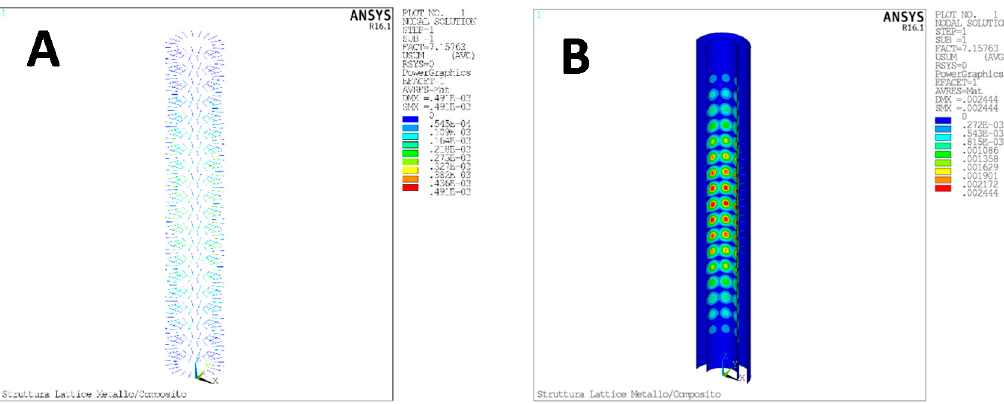
Figure 30. Test Case 3—1st buckling mode—Total Displacement. ( A ) only lattice structure; ( B ) only internal and external skins.